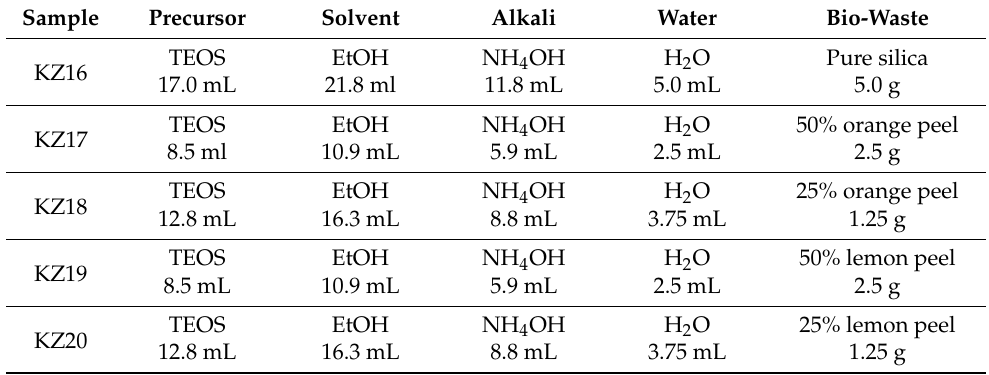
Table 4. Conditions employed in silica synthesis using ammonium hydroxide as a catalyst. Sample